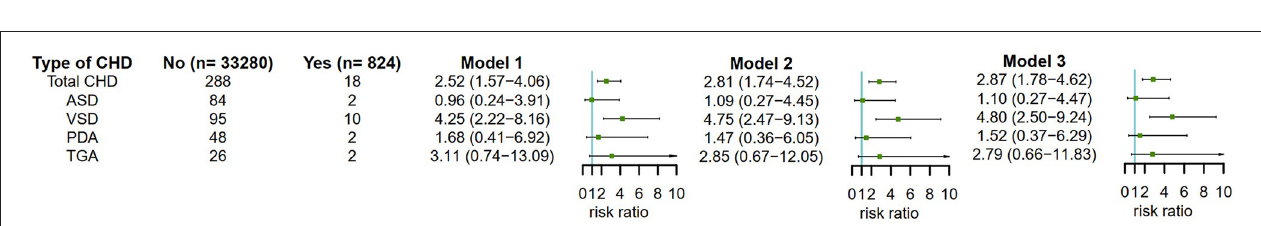
FIGURE 3 | Maternal antidepressant use in 3 months before pregnancy and risk of CHD and its phenotypes in offspring. Model 1 was a crude model without any variable adjusted. Model 2 adjusted for maternal age, ethnicity, residence location, education level, history of gestational diabetes mellitus and history of gestational hypertension. Model 3 adjusted for maternal age, ethnicity, residence location, education level, history of gestational diabetes mellitus, history of gestational hypertension, smoking before pregnancy and alcohol drinking before pregnancy. CHD, congenital heart disease.